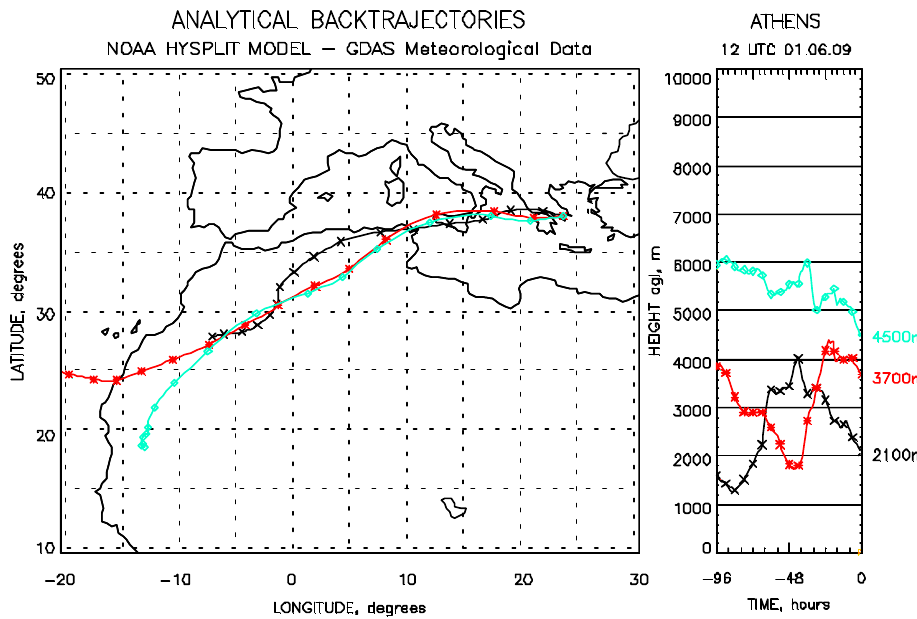
Fig. 9. Back-trajectories of air masses arriving over Athens on 1 June 2009 (12:00UT) at various heights (2100m, 3700m, 4500m). Time step is 6